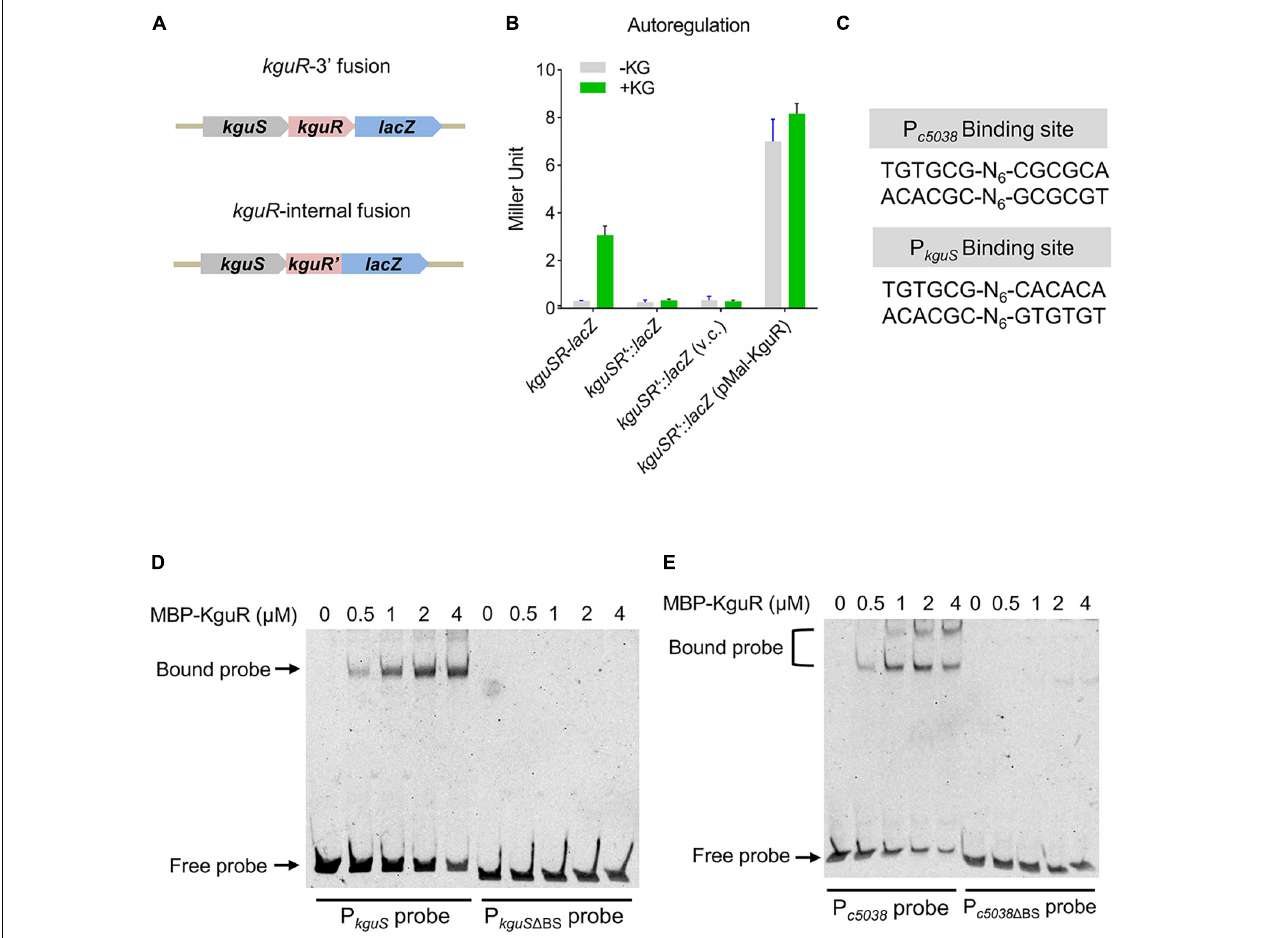
FIGURE 4 | KguR directly autoregulates its own expression. (A) A schematic showing the construction of kguSR - lacZ fusion strain. (B) KguR autoregulates its own expression. KG, α -ketoglutarate; and v.c., vector control. The means ± SEM from three independent experiments are presented. (C) KguR binding sites in the promoter regions of c5038 and kguS . N stands for random nucleotides between the imperfect inverted repeats. (D,E) Binding of KguR protein to native and mutant promoters of c5038 (D) and kguS (E) . Purified MBP-KguR fusion protein was added in different concentrations in each reaction mixture as indicated. DNA probes were stained with SYBR green nucleic acid stain. BS, binding